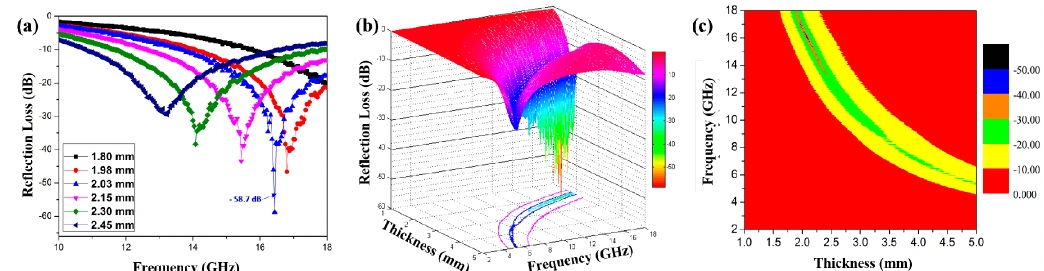
Figure8. Simulationofreflectionloss(RL)curves( a ), 3DrepresentationsofRL( b )andthecorresponding Figure 8. Simulation of reflection loss (RL) curves ( a ), 3D representations of RL ( b ) and the contour map ( c ) of sample B with a filler loading ratio of 6 wt% in wax corresponding contour map ( c ) of sample B with a filler loading ratio of 6 wt% in wax composites.